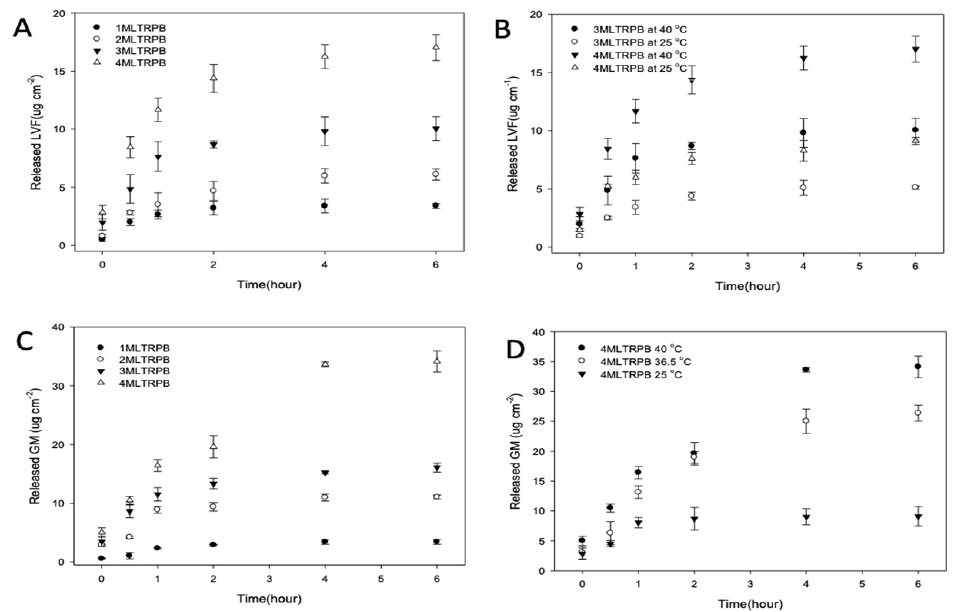
Figure 5. ( A ) LVF released into Milli-Q water from MLTRPB on Ti implants at 40 ◦ C, ( B ) LVF released from 3- and 4-MLTRPB at different temperatures, ( C ) GM released into PBS buffer-D 2 (pH 7.0) at 40 ◦ C, and ( D ) GM released from 4-MLTRPB at different temperatures .